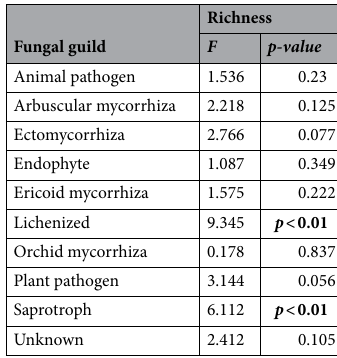
Table 1. F and p values for LME comparisons of guilds among treatments. *Significant p values are shown in bold.